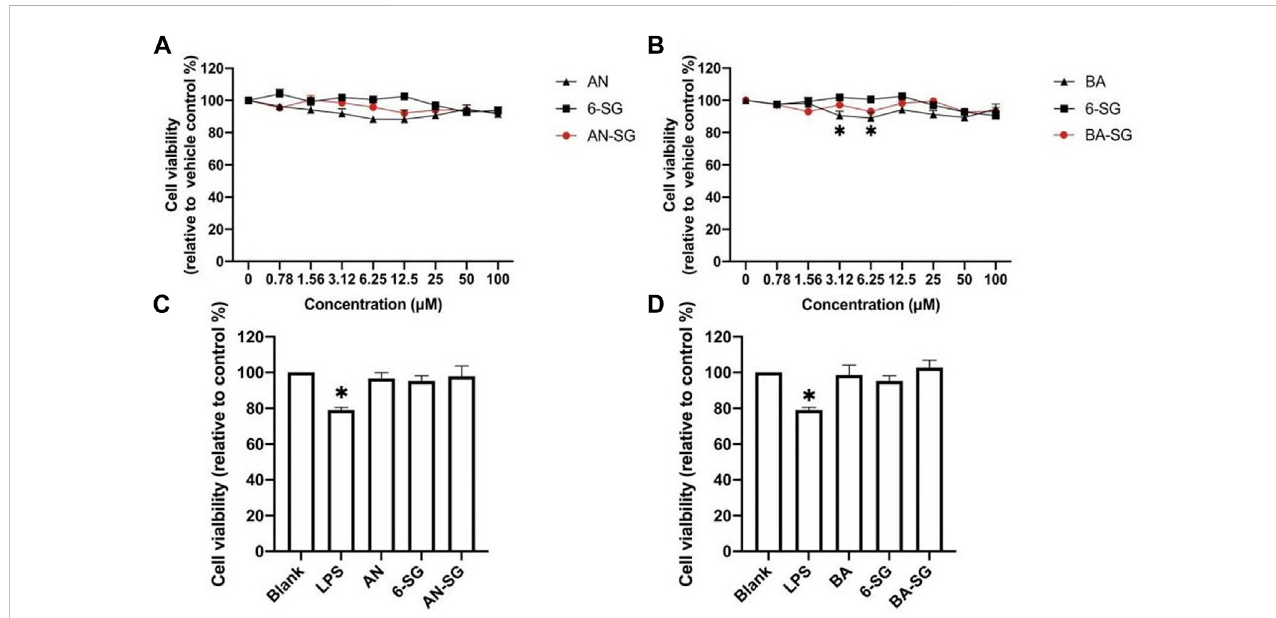
FIGURE 1 CellviabilityofN11cellsinthemono-culturetreatedbyAN,BA,6-SGandtheircombinations,AN-SGandBA-SG. (A) Thedose-responsecurveofthecell viability treated by AN, 6-SG and AN-SG at 0.78 – 100 µM in N11 cells. (B) The dose-response curve of the cell viability treated by BA, 6-SG and BA-SG at 0.78 – 100 µM in N11 cells. (C) Cell viability of N11 treated by AN, 6-SG and AN-SG at 25 µM. (D) Cell viability of N11 treated by BA, 6-SG and BA-SG at 25 µM * p < 0.05 vs. Blank (cells with vehicle control) analysed by one-way ANOVA with Tukey test. Data are shown as mean ± SEM ( n = 3).